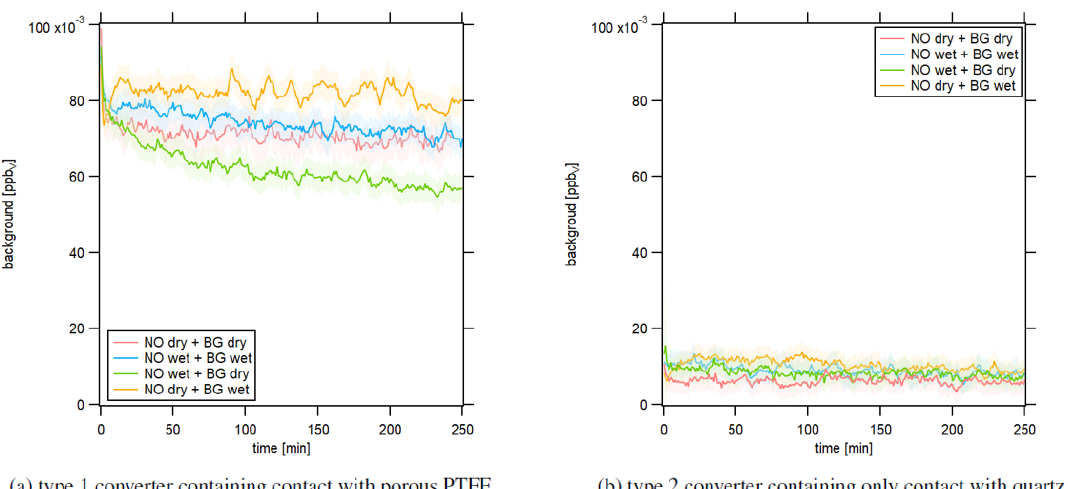
Figure 6. Instrumental background in response to dry and humid conditions after 2h of NO calibration at 15.8ppbv in the NO c channel. The LEDs of the photolytic converter were switched